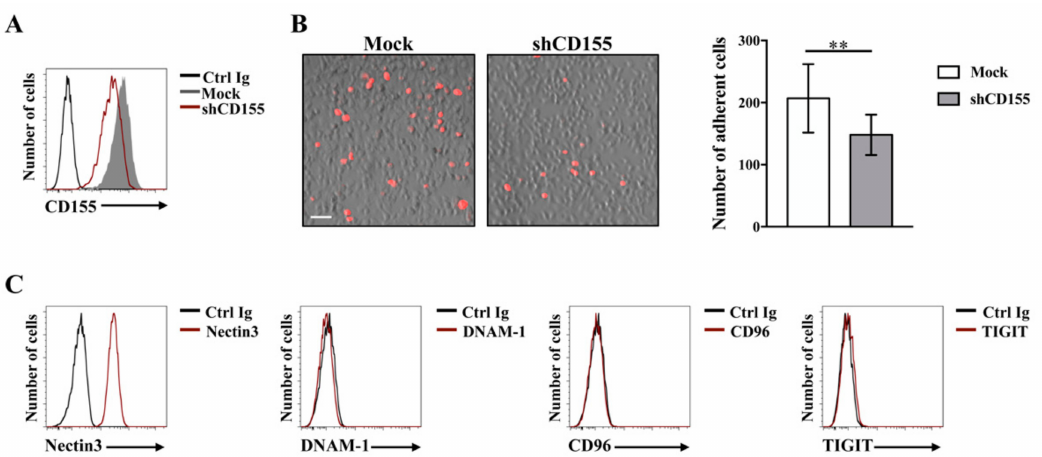
Figure 2. CD155 promotes Multiple Myeloma (MM) cell binding to bone marrow stromal cells (BMSCs). ( A ) CD155 knock-down in the Multiple Myeloma cell line ARK was achieved by means of lentiviral-mediated shRNA targeting (pLKO vector, MISSION ™ Sigma-Aldrich). CD155 surface expression was analyzed by FACS in cells infected with shCD155 (code SHCLND-NM_006505, sequence TRCN0000062911) (empty red histogram) or non-targeting shRNA (Mock, filled gray histogram) by mean of a PE-conjugated anti-CD155 monoclonal Ab (clone SKII.4, Biolegend). Isotype control staining